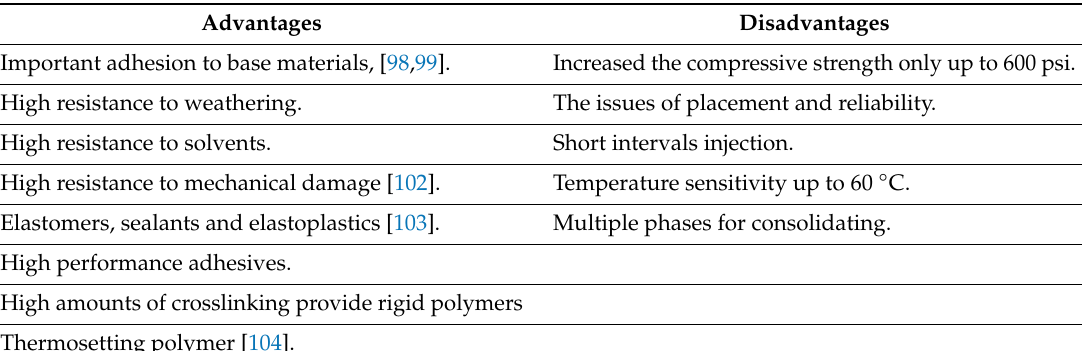
Table 20. Advantages and disadvantages of polyurethane resins methods.